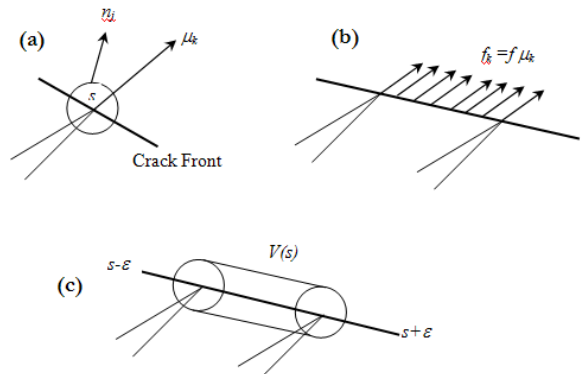
Figure 4: A schematic diagrams of elements used in the definition of the interaction integral: (a) crack front and contour, (b) line load applied along the crack front and (c) volume V ( s ) encloses the crack front segment. R ESULTS AND